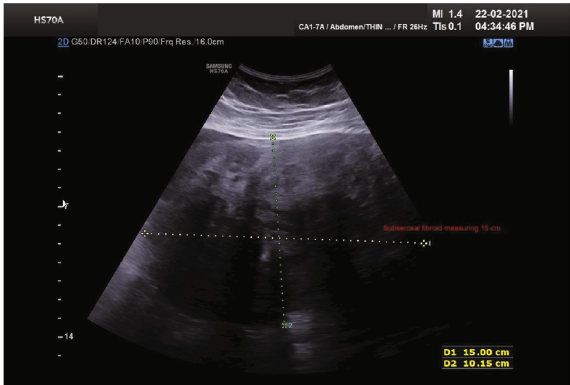
Figure 2: Ultrasound of the lower abdomen showing fi broid measuring about 15cm.